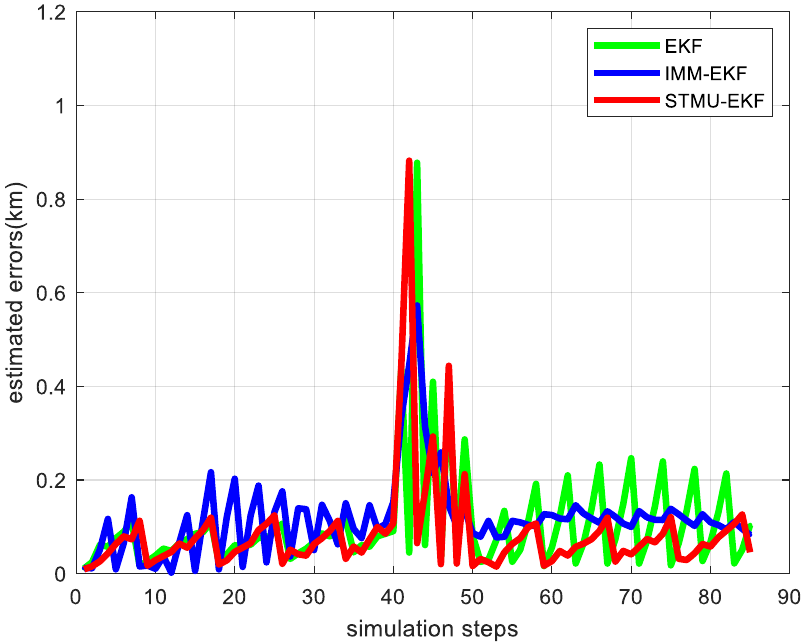
Figure 8. The target tracking error in the multi-sensor collaborative management model.